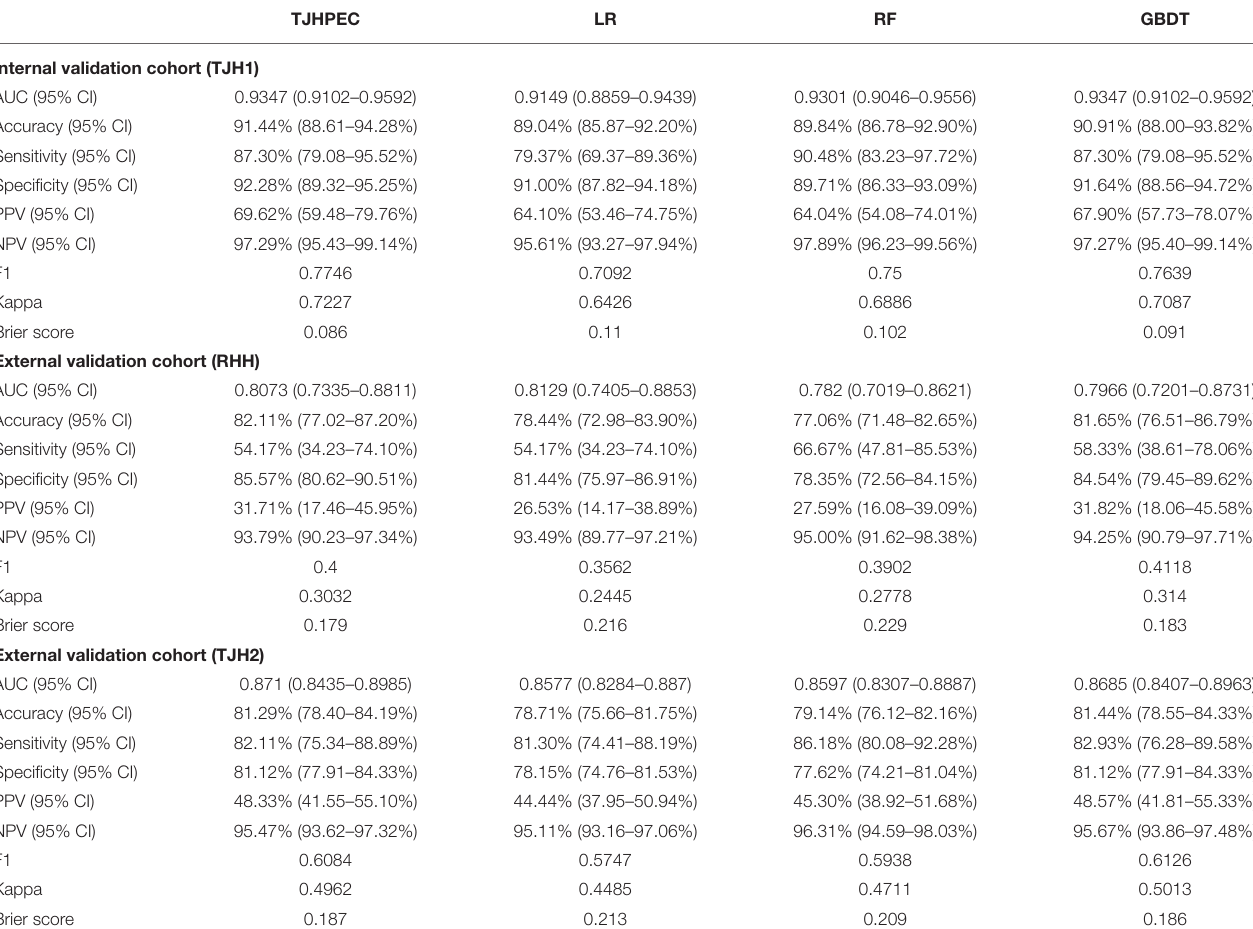
TABLE 3 | Performance indices of the four predictive models for stage I EC in validation